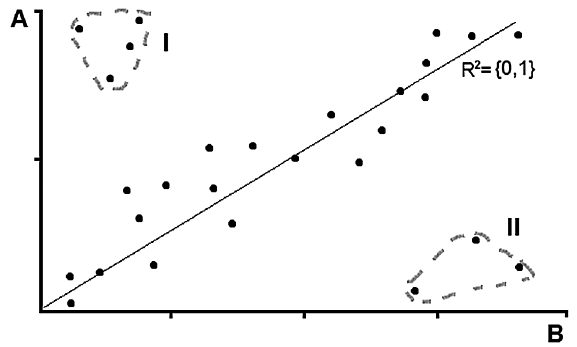
Fig. 2. Example of correlation diagram between researched